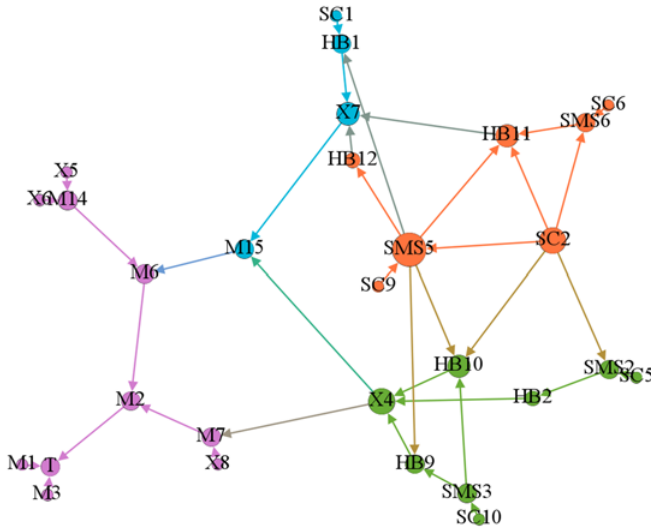
Figure 6. Results of the associated analysis of UC M2 accident causal factor.